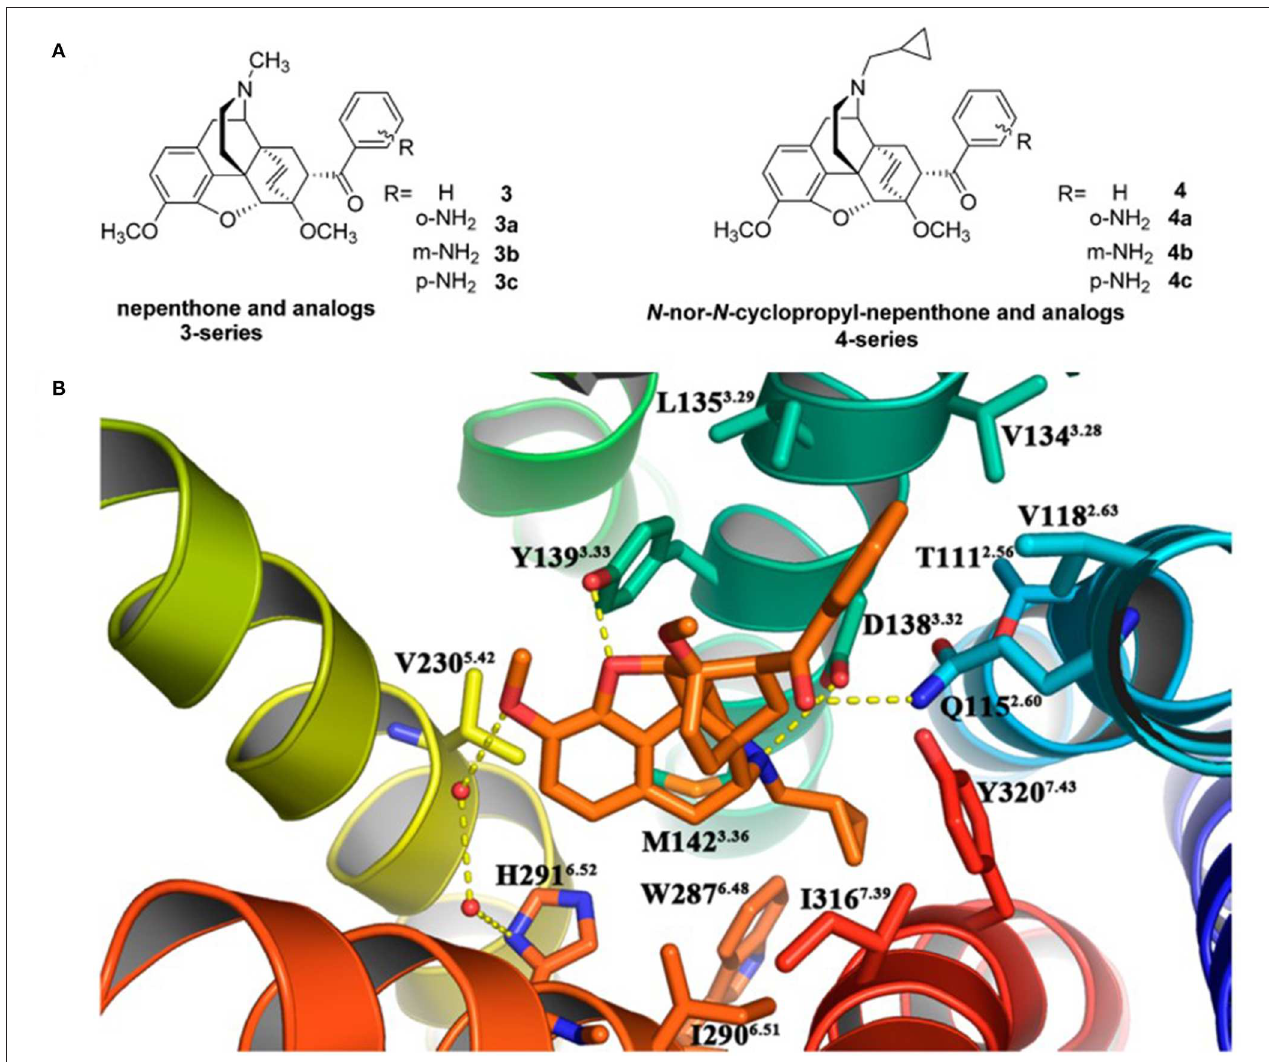
FIGURE 3 | (A) Design for novel κ OR agonists from nepenthone (3-series) and N-nor-N-cyclopropylmethyl-nepenthone derivatives (4-series). (B) Binding mode for 17-nor-N-cyclopropylmethyl-nepenthone (compound 4 , colored in orange) at the agonist-binding site of KOR. The 7 α -phenylcarbonyl group orientated very well inside the hydrophobic subpocket composed of residues Trp124 ECL2 , Leu135 3.29 , Val118 2.63 , Val134 3.28 , and Gln115 2.60 . Hydrogen bonding interactions are shown by yellow dotted